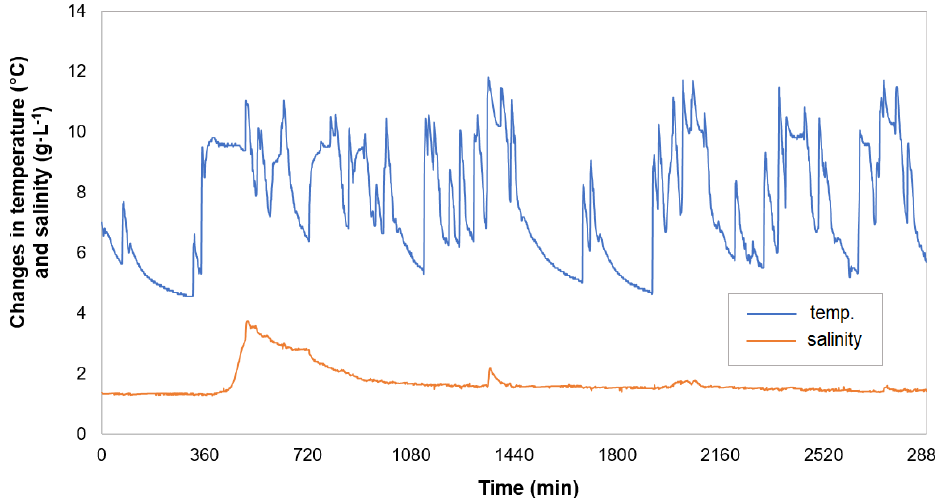
Figure 10. Changes in the temperature and salinity of treated wastewater, during an example of two days of the winter period.